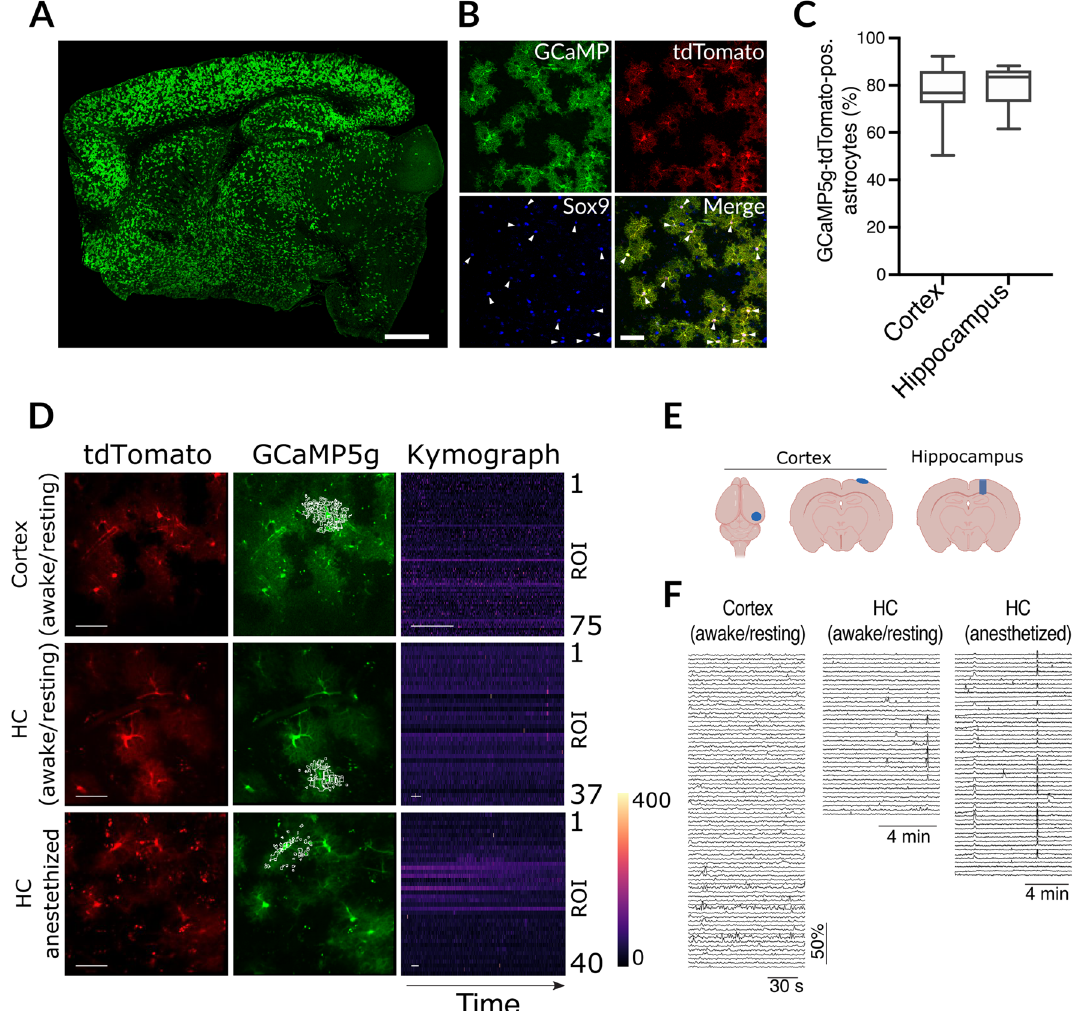
using GCaMP5g native fluorescence. The kymographs represent color-coded calcium changes over time (scale bars, 30 s) in distinct regions of interest (ROI) from individual astrocytes (marked by white boxes in the GCaMP5g images). ( E ) Locations of cranial windows implanted over cortex and hippocampus. ( F ) Individual traces for all conditions and regions. The traces correspond to ROIs and kymographs depicted in D. Mice were 4 months of